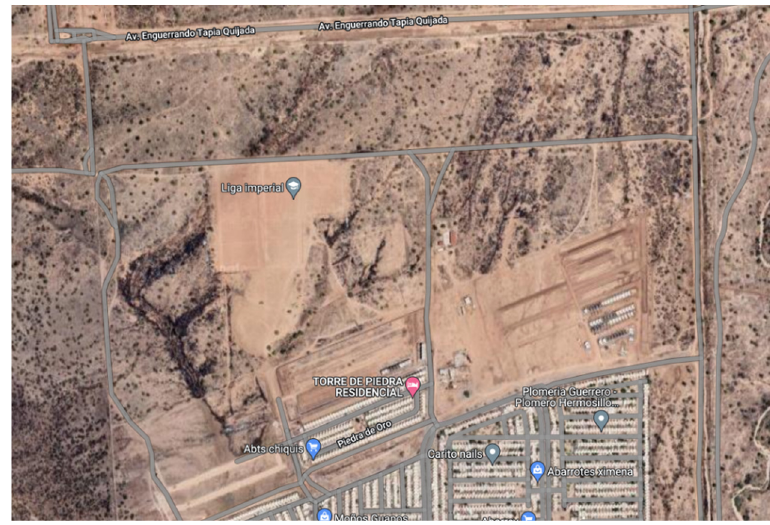
Figure 13. Google Maps shows “Liga Imperial” as the new soccer club.